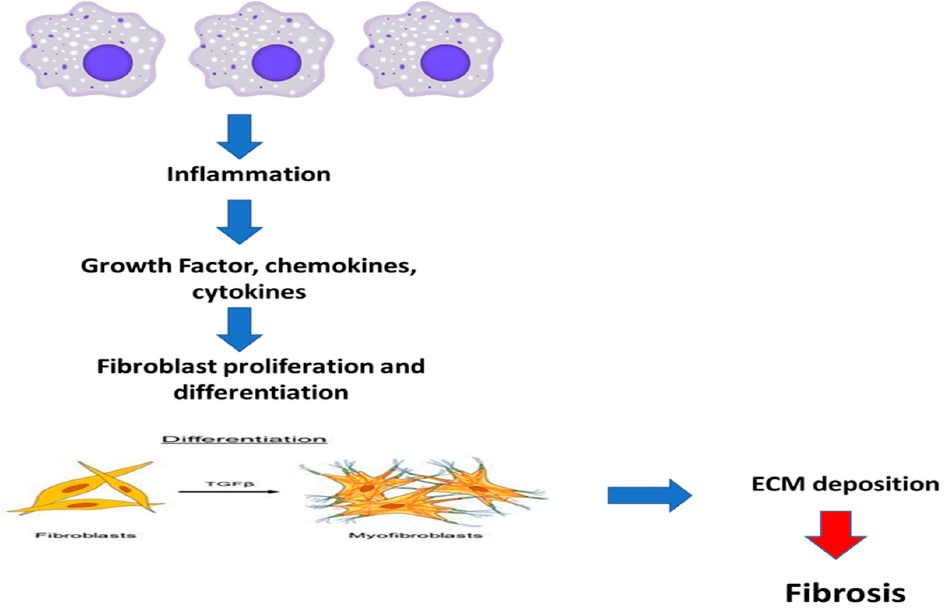
Figure 8. The schematic diagram illustrates how fibrosis is triggered by persistent inflammation. TFG- β ; transforming growth factor.